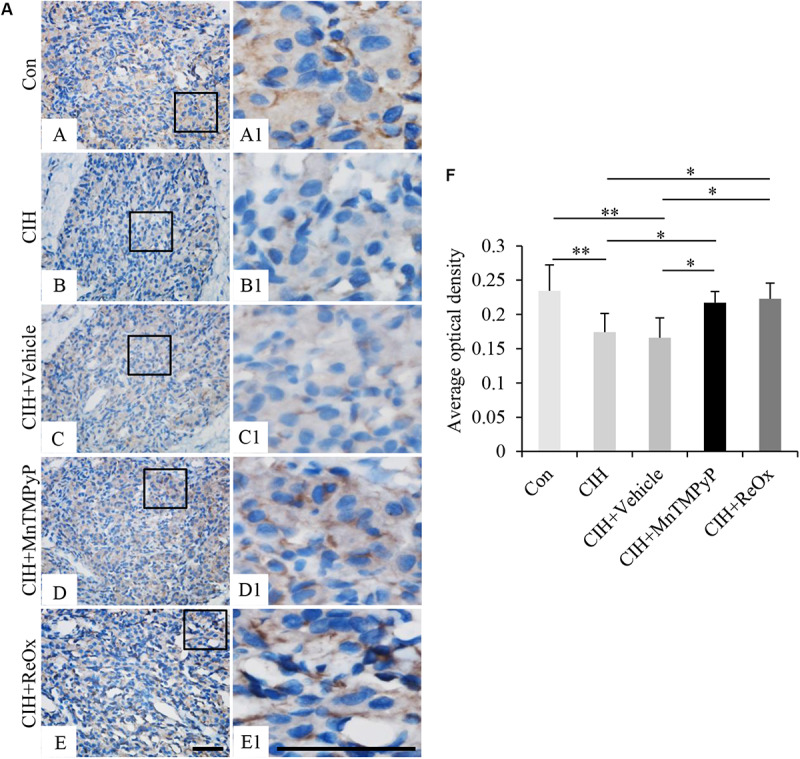
The effect of MnTMPyP and reoxygenation on the BACE1 level in the rat CB. (A) Immunohistochemical staining of BACE1 in the CB from Control (Con) (A,A1), CIH (B,B1), CIH + Vehicle (C,C1), CIH + MnTMPyP (D,D1), and CIH + ReOx (E,E1) group rats. (A1–E1) are higher magnification images of rectangle areas in (A–E), respectively. The brown color represents BACE1 staining, while the blue color represents hematoxylin-stained cell nuclei. (F) Statistical analysis of BACE1 protein expression levels in rat CB after CIH treatment. The data were presented as means ± S.D. MnTMPyP: scavenger of ROS, CIH: cyclic intermittent hypoxia, ReOx: reoxygenation. n = 7 in each group, Scale bar = 50 μm for all images, *P < 0.05, **P < 0.01.